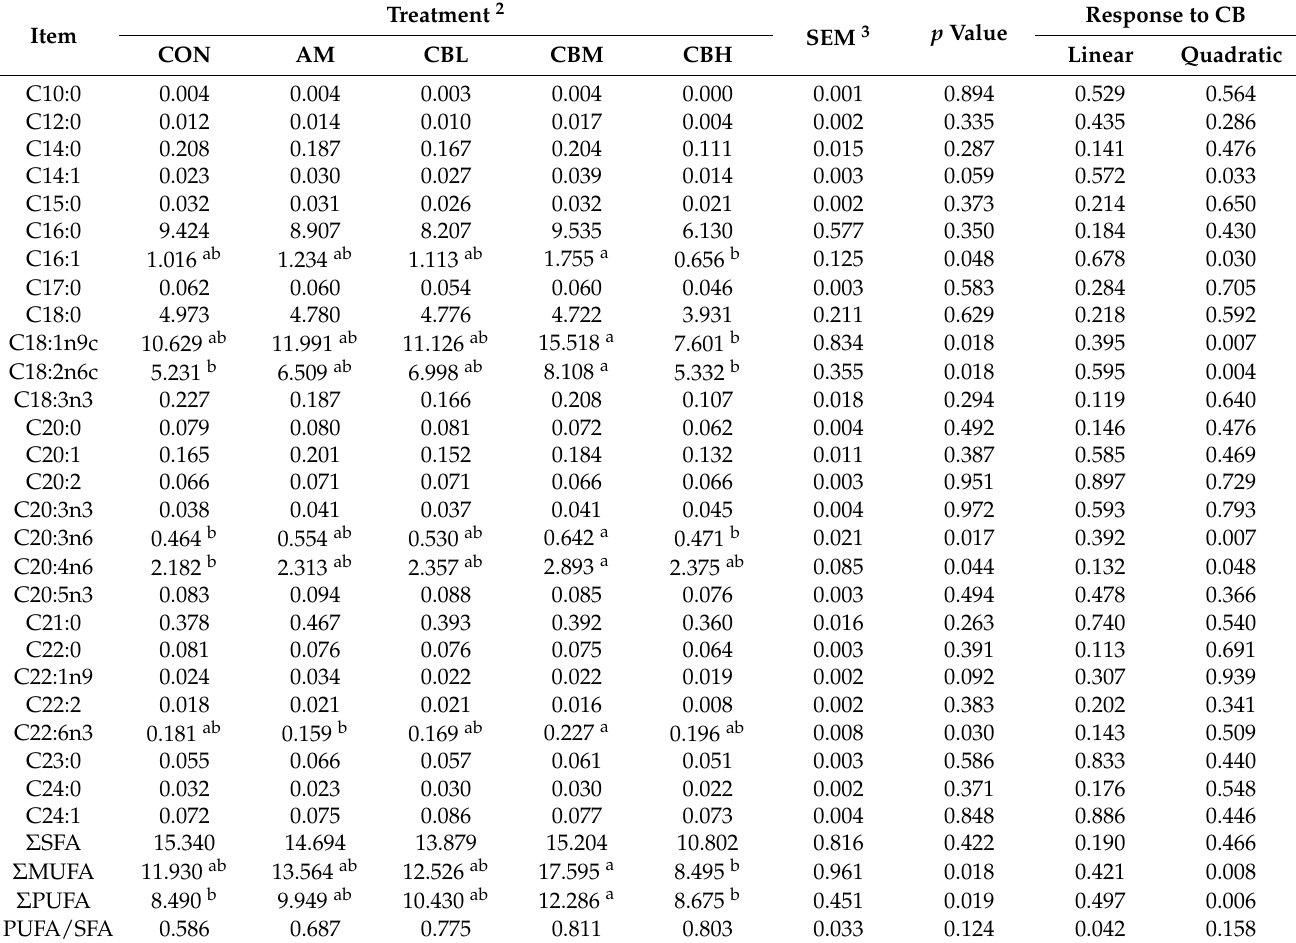
Table 5. Effects of C. butyricum on fatty acid composition (mg/g) in breast muscle of broilers 1 .